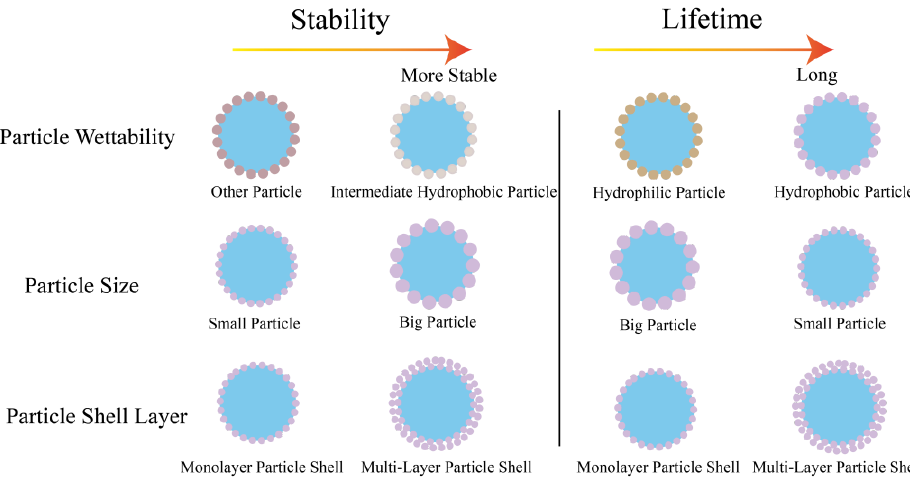
Figure 4. The stability and lifetime of various LMs with different types of particle shells.